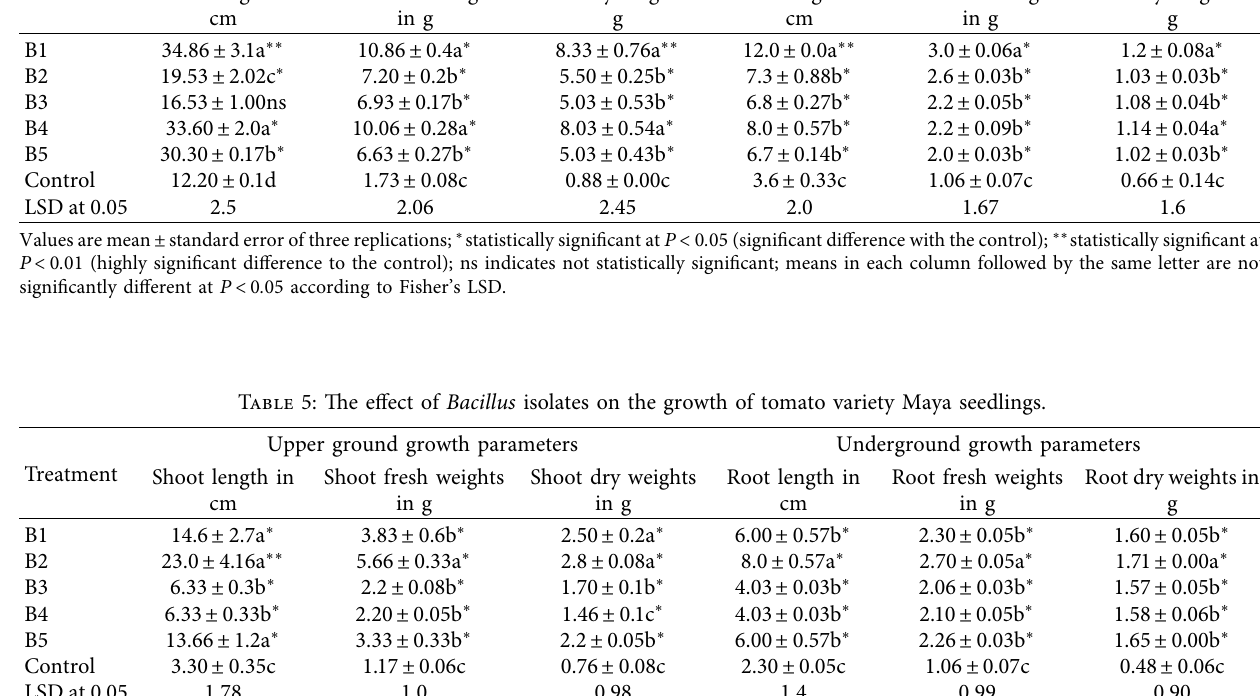
Table 4: The effect of Bacillus isolates on the growth of tomato variety Kochero seedlings. Treatment